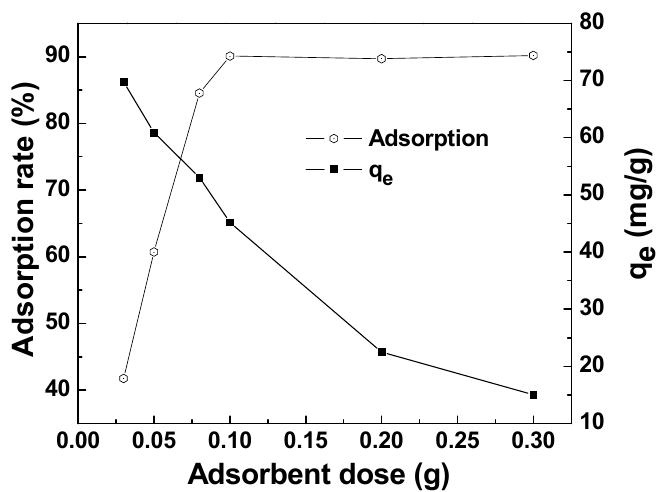
Figure 8. Effect of adsorbent dose on the adsorption of MAFC to emulsified oil ( emulsified oil 100 mg/L, contact time 30 min, reaction temperature 25 °C).